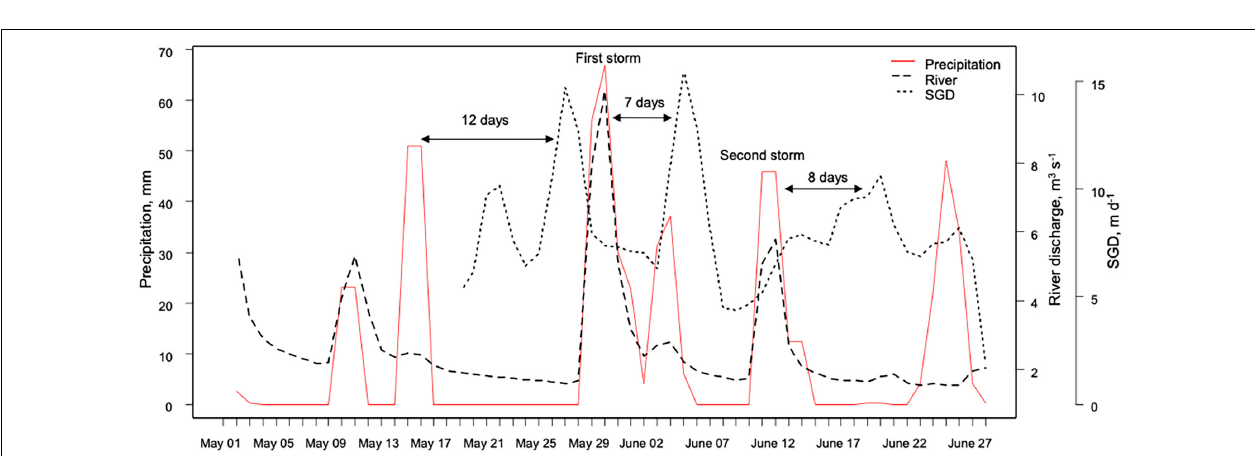
FIGURE 4 | Cumulative precipitation, river discharge, and SGD during and 2 weeks prior to the sampling